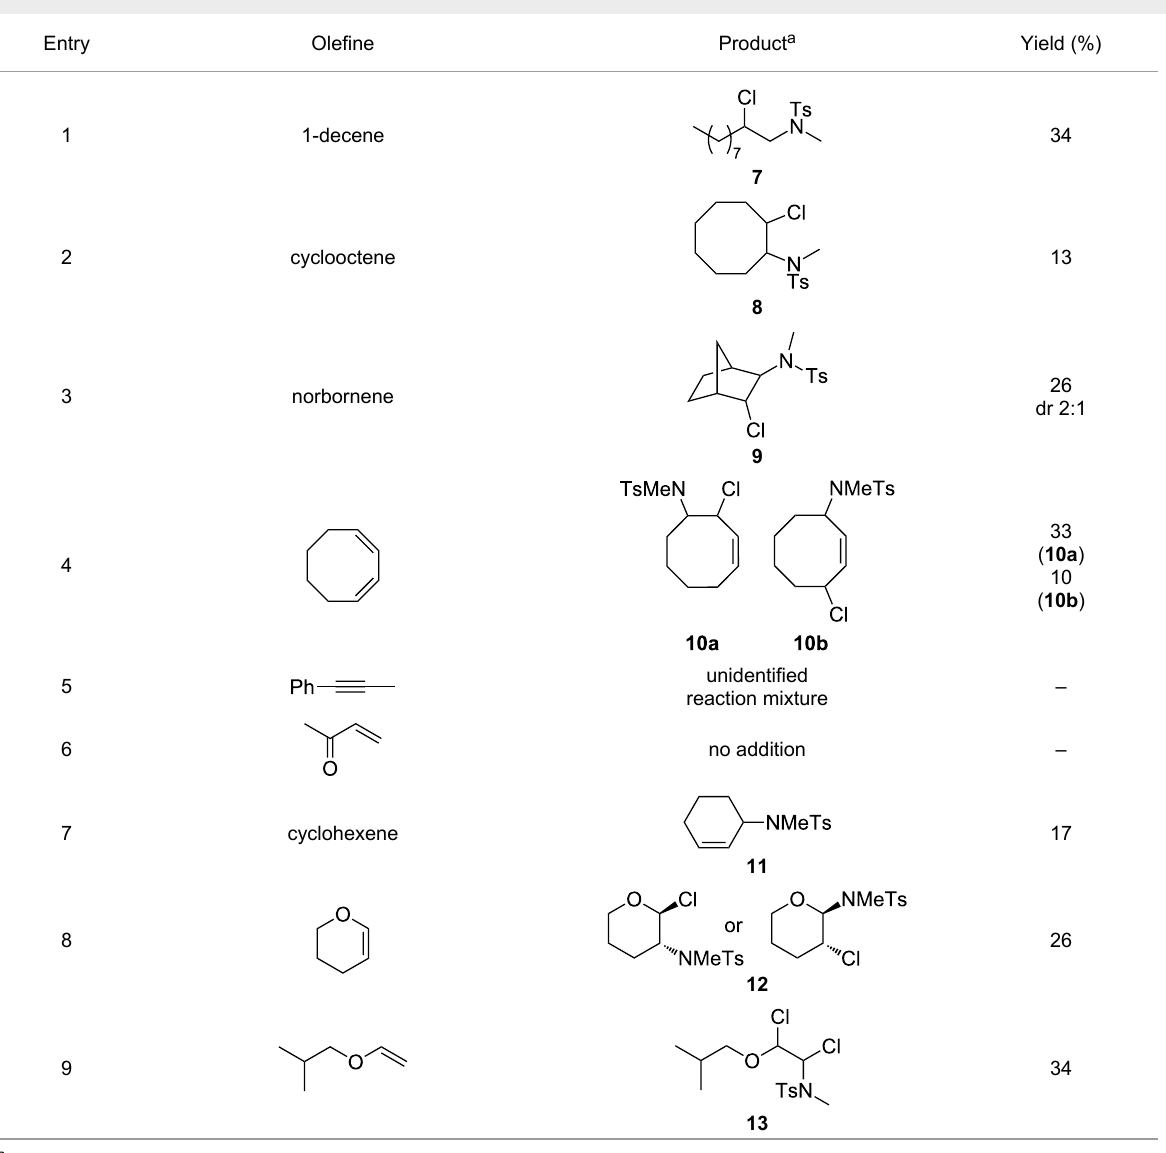
Table 3: Addition reactions of 2a with electron-deficient